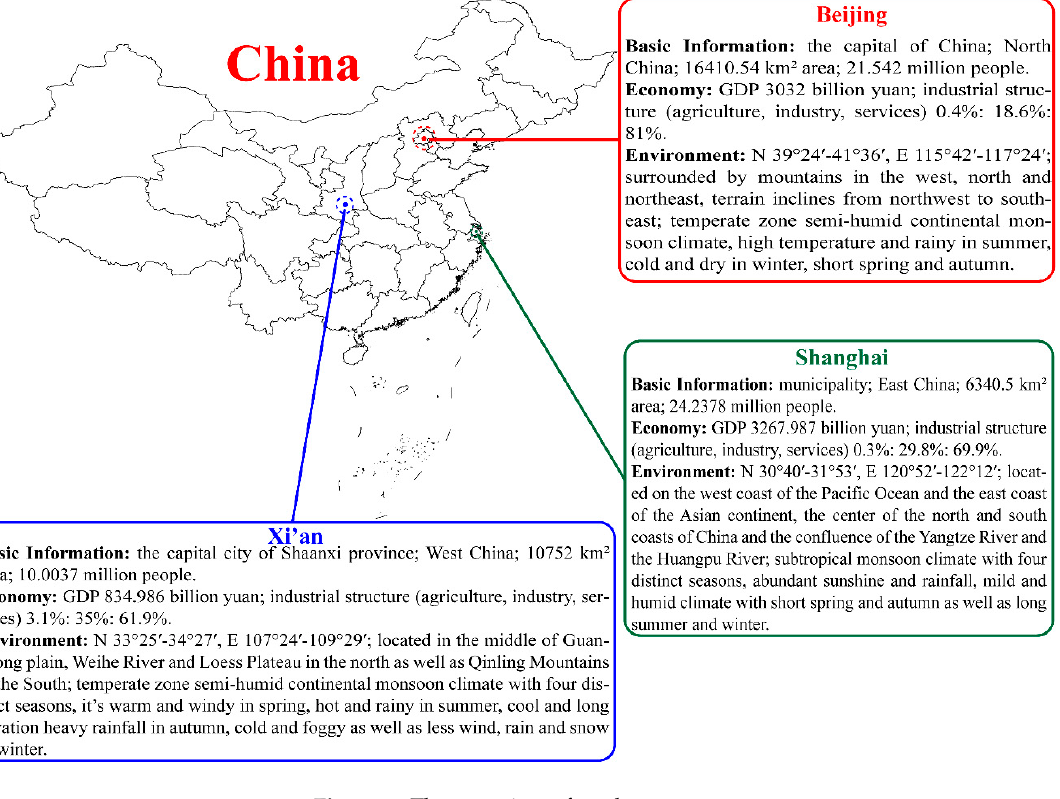
Figure 2. The overview of study areas.